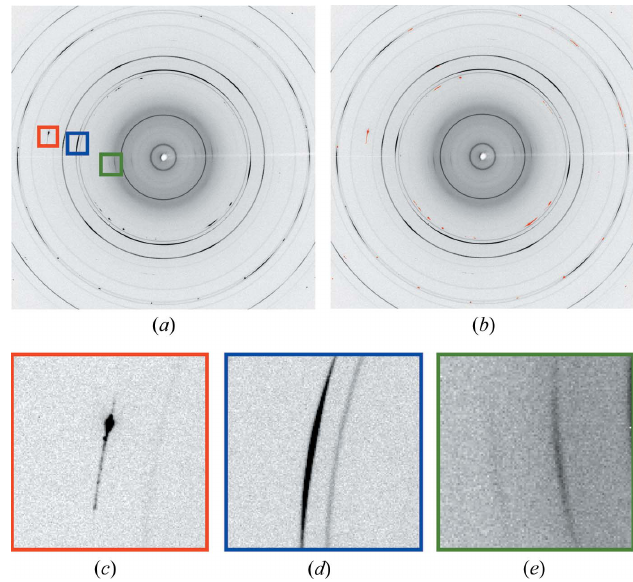
Figure 1 ( a ) Raw experimental XRD pattern and ( b ) its masking result. The red, blue and green boxes in ( a ) show ( c ) single-crystal diffraction spots, ( d ) preferred orientation (the darker line) and two texture lines. Panels ( a ) and ( b ) are cropped for visualization purposes.